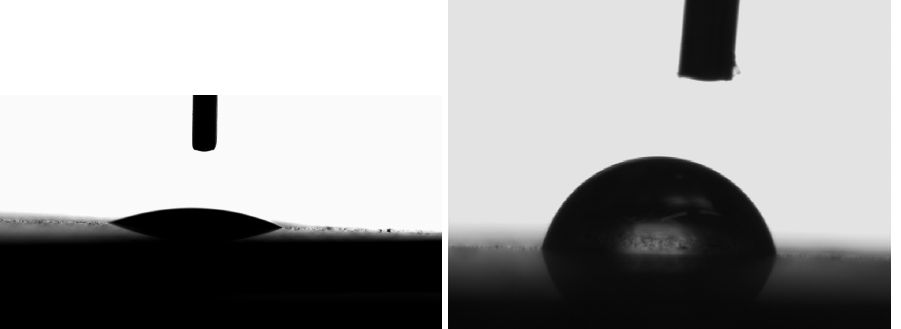
Figure 8. Contact between water and ( left ) oxidized PS surface and ( right ) oxidized PS surface treated with